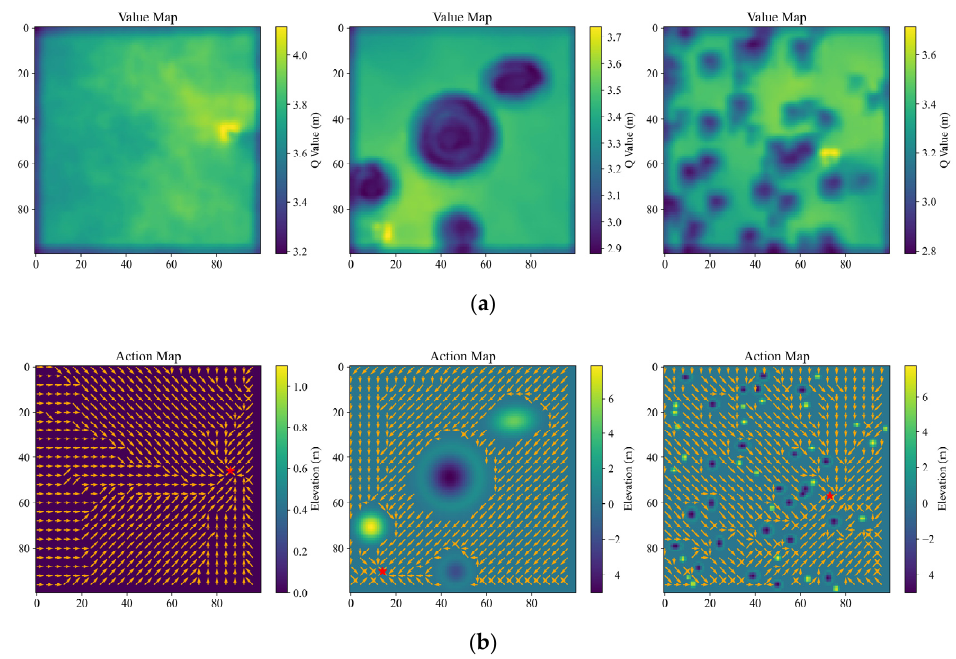
Figure 7. Visualized evaluation of the block planner: ( a ) value map, ( b ) action map.